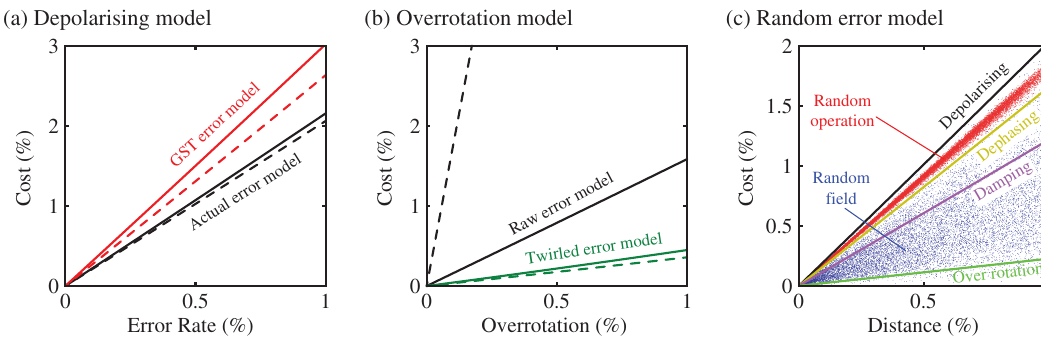
FIG. 3. Cost ( C − 1 ) for correcting errors. We consider a universal set of operations, including the initialization, measurement, single- qubit Clifford gates, a single-qubit non-Clifford gate, and a two-qubit entangling Clifford gate. Sixteen basis operations of each qubit can be generated using these operations. Every operation in the set has error, and the memory error is also included. We assume that qualities of the initialization and single-qubit gates are 10 times better than the measurement and two-qubit gates, and also that the quality of the memory operation is 100 times better. Details of the model are given in Appendix H. The cost for correcting error in each operation in the universal set is calculated, and the maximum cost over all operations is plotted. (a) For the depolarizing error model, the cost is lower if we directly use actual operations to correct errors, and the cost is higher if we use gate set tomography (GST) estimations to correct errors. (b) For the overrotation model, the cost is higher without using the Pauli twirling, and the cost is lower when the Pauli twirling is used. In (a) and (b), solid curves correspond to the compensation method (with the optimized λ ), and dashed curves correspond to the inverse method. (c) The cost as a function of the distance between operations with errors and operations without error. For the operation with error O and the operation without error O ð 0 Þ , the distance is ϵ O ¼ k O − O ð 0 Þ k . The x axis illustrates the max maximum distance over all operations in the universal set. In (b) and (c), we always use GST estimations. In (c), Pauli twirling and the inverse method are used for all the data. Pauli twirling is applied to the measurement and two-qubit gate, and the inverse method is applied only to the two-qubit gate, while errors in other operations are corrected using the compensation method. We remark that usually the maximum distance and the maximum cost are given by the two-qubit